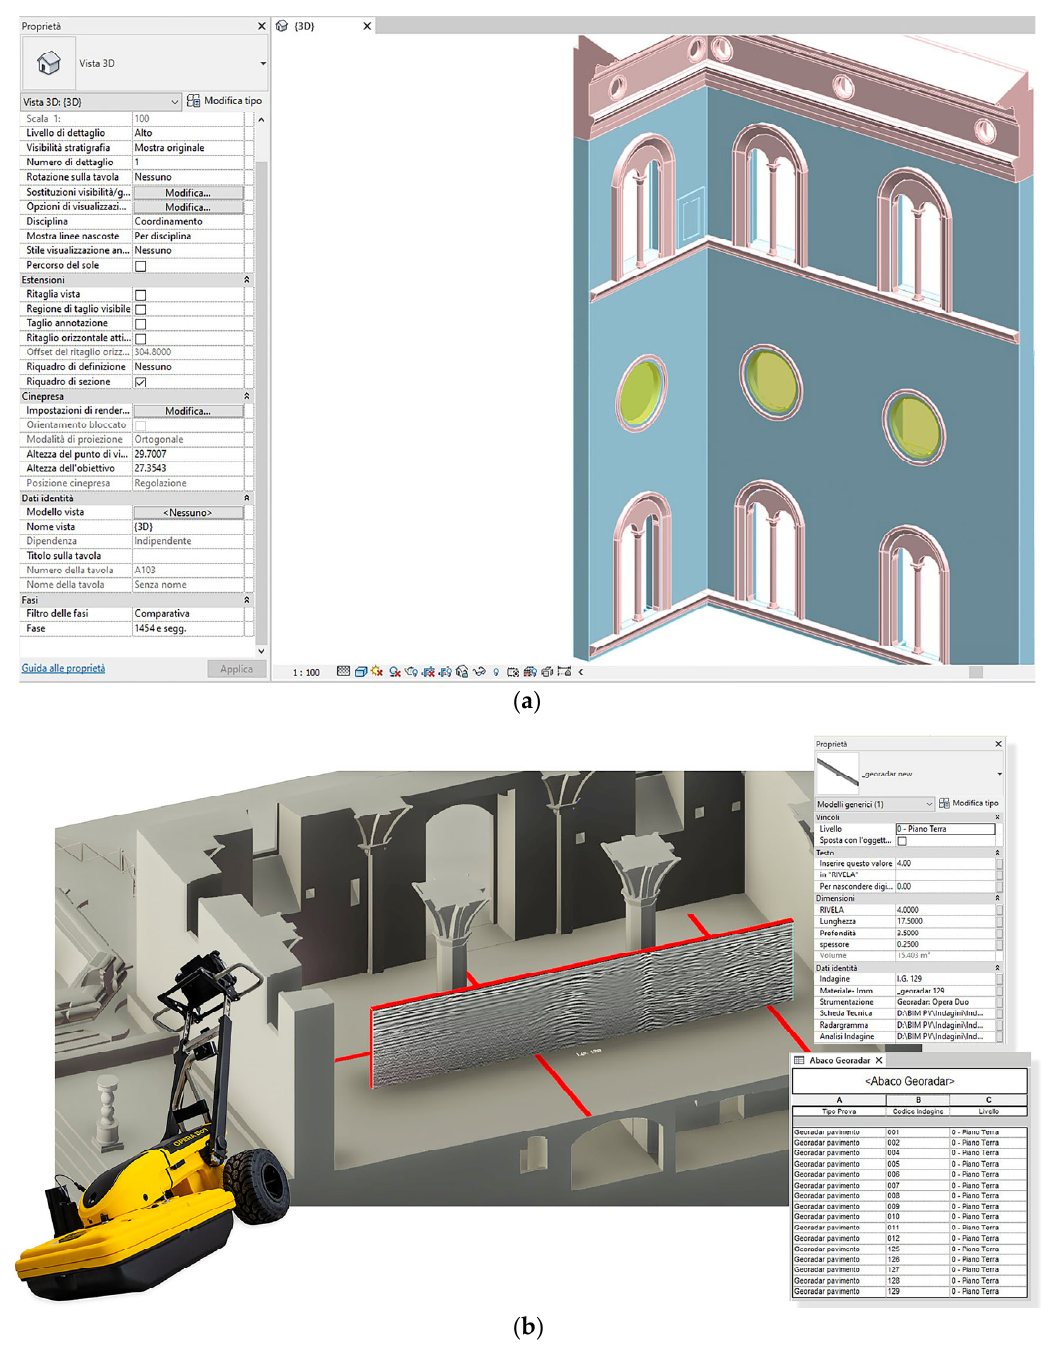
Figure 10. ( a ) Chronological phases inside the H-BIM plo tt ed for year 1454 A.D; in pink, the new additions proposed at the time, in yellow, the demolitions occurred to realize the new openings; ( b ) From the building to the BIM model: GPR radargrams are visible into the 3-d model in the exact position where the campaign was